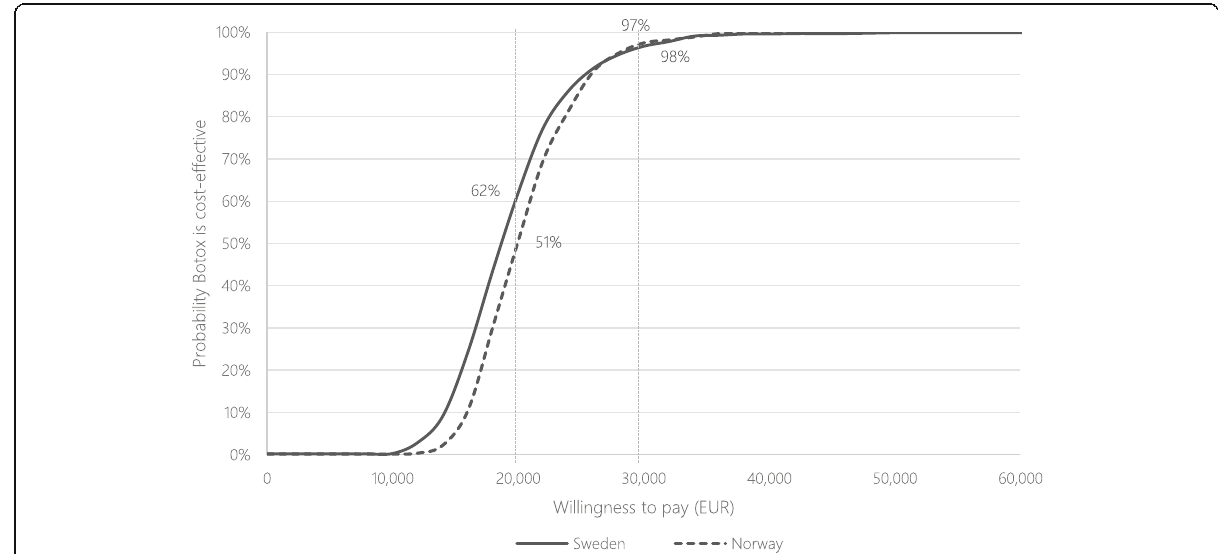
Fig. 6 Cost-Effectiveness Acceptability Curve (CEAC). Note: WTP levels of EUR 20,000 and EUR 30,000 are indicated by the grey vertical